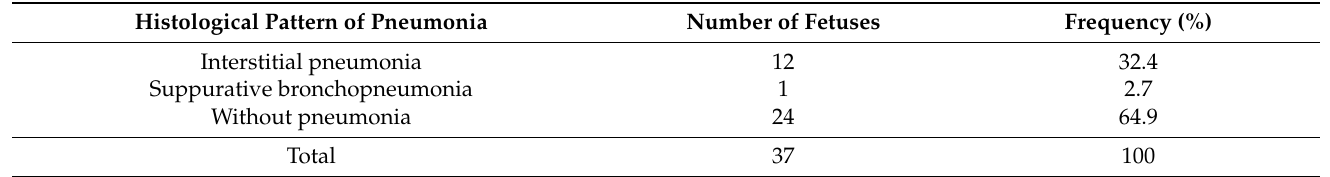
Table 2. Patterns of pulmonary disease observed in fetuses from southern and midwestern Brazil.